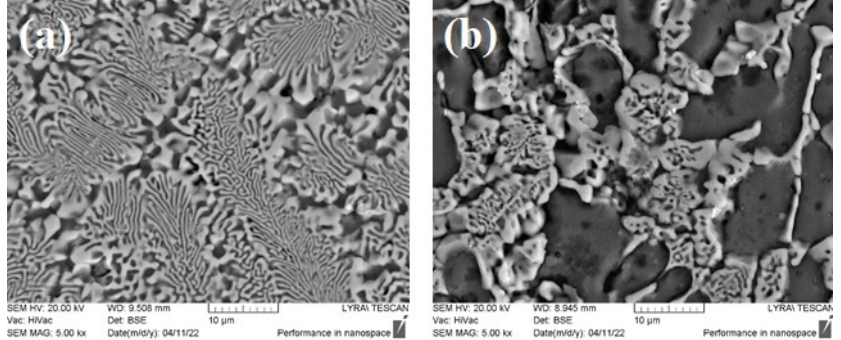
Figure 5. Highly magnified SEM images of the fusion zone of Cu/Al6082T6 samples: ( a ) sample 1, prepared with r osc = 0.1 mm; ( b ) sample 2, prepared with r osc = 0.2